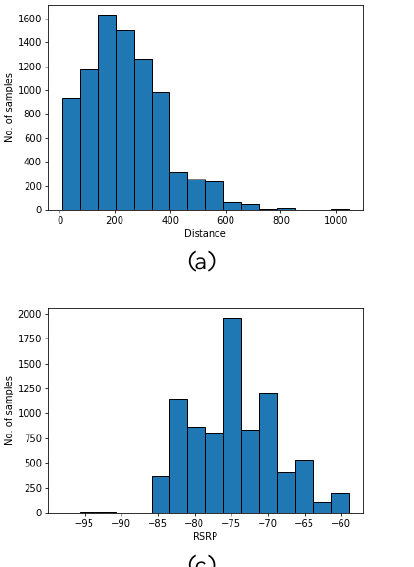
Figure 7. Histograms of dataset parameters, including ( a ) distance, ( b ) angle, ( c ) RSRP, and ( d ) RSRQ.